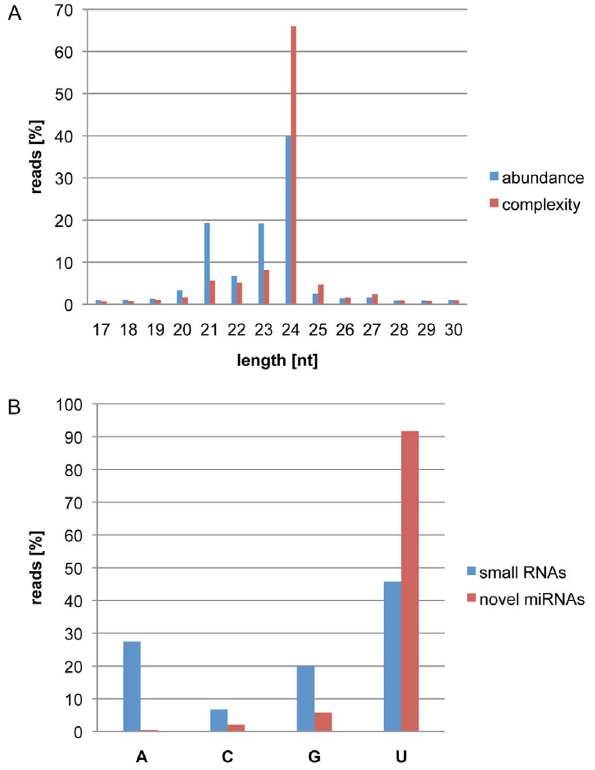
Figure 1. Characterization of Small RNAs in Soybean Cotyle- dons. (A) Abundance and complexity distribution of small RNAs at each size in soybean cotyledons: The percentages of 253 million qualified small RNA reads at each given size (abundance, in blue) and the percentages of 41 million unique small RNA species at each given size (complexity, in red) are indicated on the Y-axis. Sizes of the small RNA reads are displayed on the X-axis. (B) Highly biased presence of U at 5 9 ends of newly discovered cotyledon miRNAs: The percentages of 253 million qualified reads for each nucleotide at their 5 9 end (blue column) and the percentages of newly discovered miRNA reads for each nucleotide at their 5 9 end in cotyledons (red column) are shown on the Y-axis. The X-axis denotes nucleotides at the 5 9 end of small RNAs or newly discovered miRNAs.